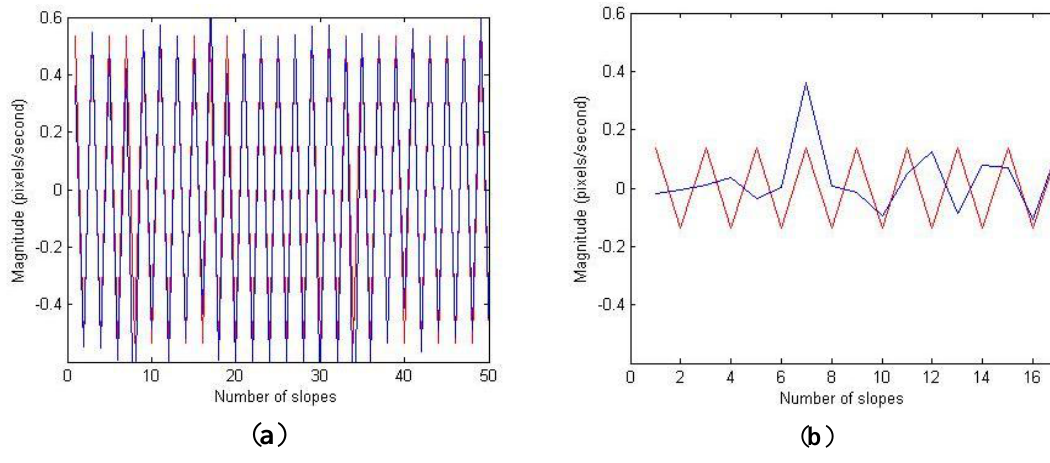
Figure 3. ( a ) The artificial perfectly-periodic slope (PPS) signal is superimposed on original slope (OS) signal for the case with V-GTS rated 0 (Normal). ( b ) The PPS is superimposed on OS for the case with V-GTS rated 4 (Extremely severe). The red line represents PPS and the blue line represents the